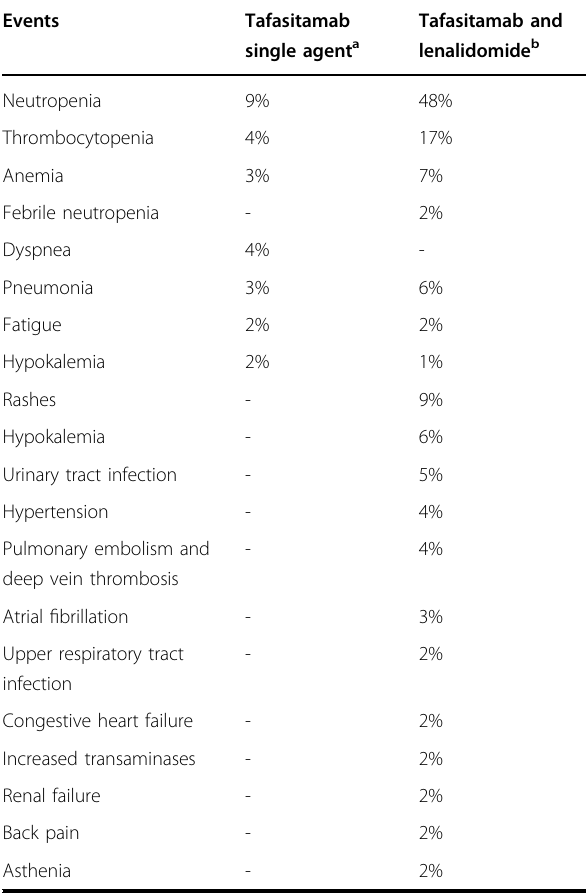
Table 2 Adverse events of grade 3 or higher encountered in NHL patients in phase II